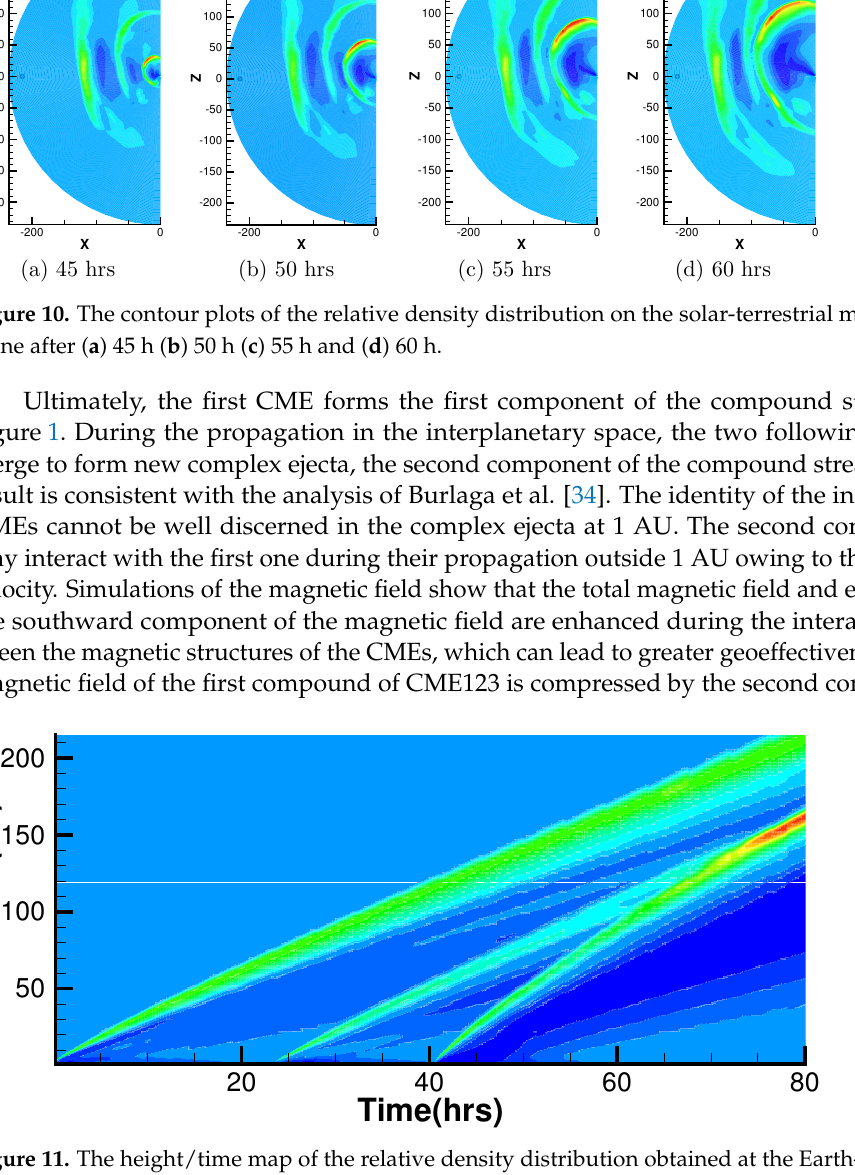
Figure 11. The height/time map of the relative density distribution obtained at the Earth-direction during 0–80 h expressed in solar radii from 1 to 215 R s for